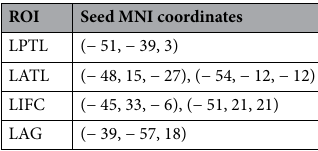
(LIFC: 30 mm) without overlap (Fig. 2a). For right-hemispheric homologues, we reversed seeds’ x -coordinate sign, growing the labels similarly. For semantic analysis ROIs, we picked an MNI seed on the cortical surface of the left temporal pole ((– 57, – 2, – 33); RATL: reversed x- coordinate), and grew it up to 40 mm, roughly covering the anterior half of the lobe (Fig. 5b). Statistical models and analyses.